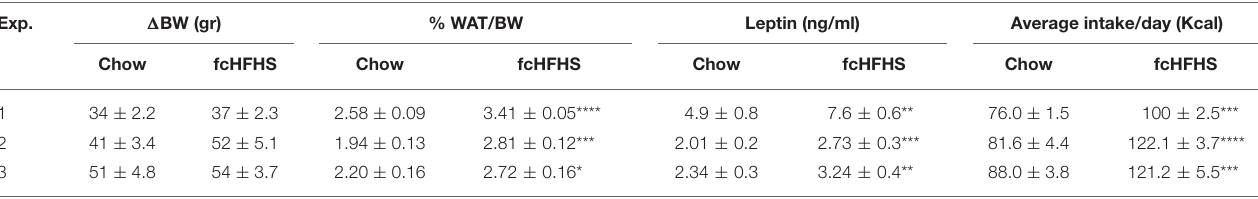
TABLE 3 | Characteristics of chow and fcHFHS animals.